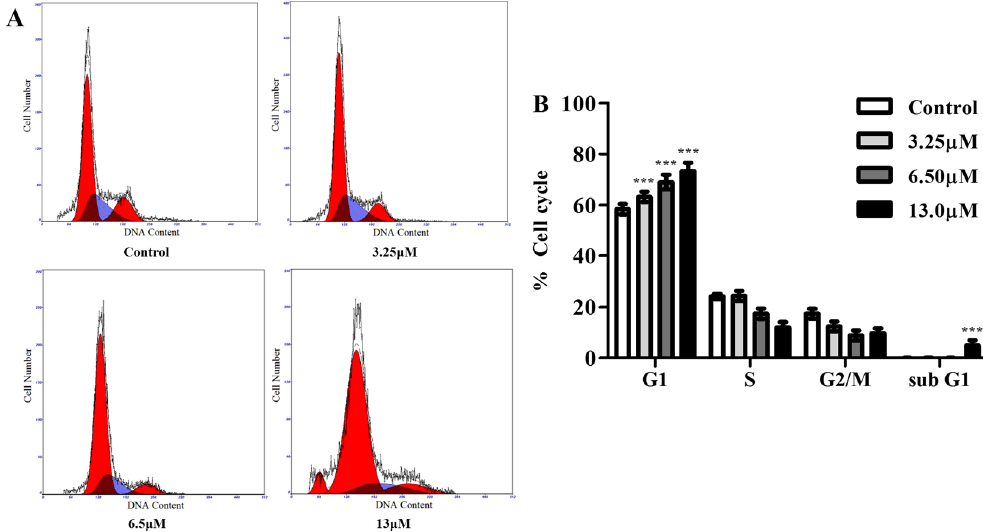
Figure 2. Flow cytometry analysis histograms of G0/G1-phase arrest in 24 h M22 treated A549 cells. ( A ) The G0/G1 peak increases with corresponding decrease in S and G2 peak in dose dependent manner. M22 treated cells at 13 μ M showing an increased sub G1 peak indicating apoptosis. ( B ) The percent of cells in different phases of cell cycle are represented by bar diagram. Data are from 3 independent experiments and analyzed by one-way analysis of variance, *** p < 0.001 compared to control. PI fluorescence was measured using a flow cytometer with FL-2